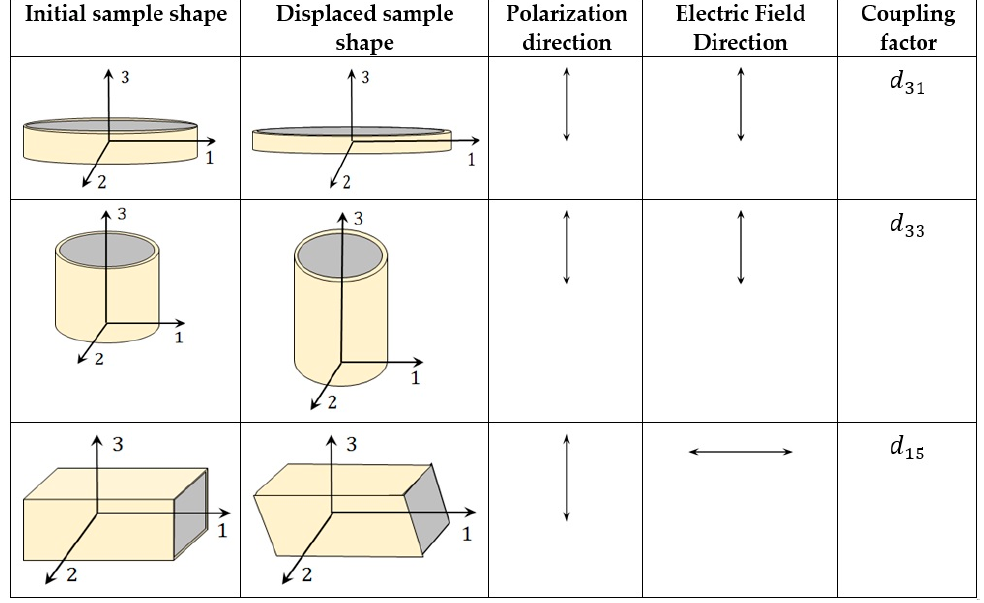
Figure 3. Typical vibration modes and corresponding piezoelectric coupling factors [75].